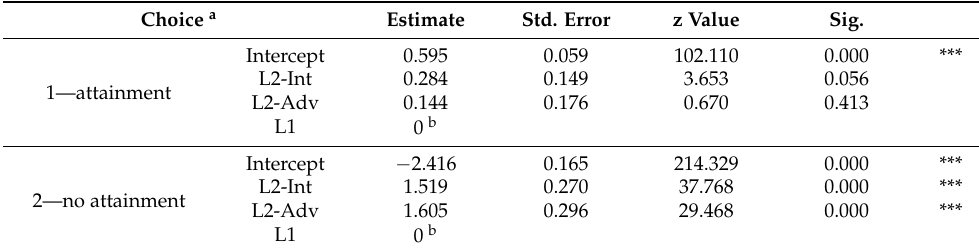
Table 4. Significant differences in choice of attainment and